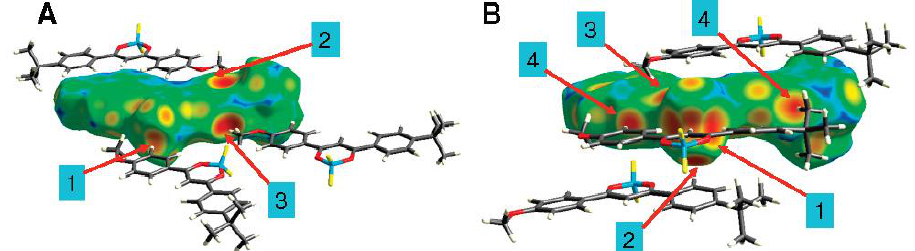
Figure 14. Crystal packing for ( A ) green and ( B ) cyan BF 2 AVB crystals, showing Hirshfeld surfaces of the central molecules mapped with d e . The most significant intermolecular interactions are as follows: (A1) C(arene)-H· · · F hydrogen bond; (A2) C(methyl)-H· · · π interaction; (A3) short H· · ·H contacts; (B1, B2) C(arene)-H· · ·F hydrogen bonds; (B3) C(methyl)-H· · ·O hydrogen bond; (B4) short H· · ·H contacts.